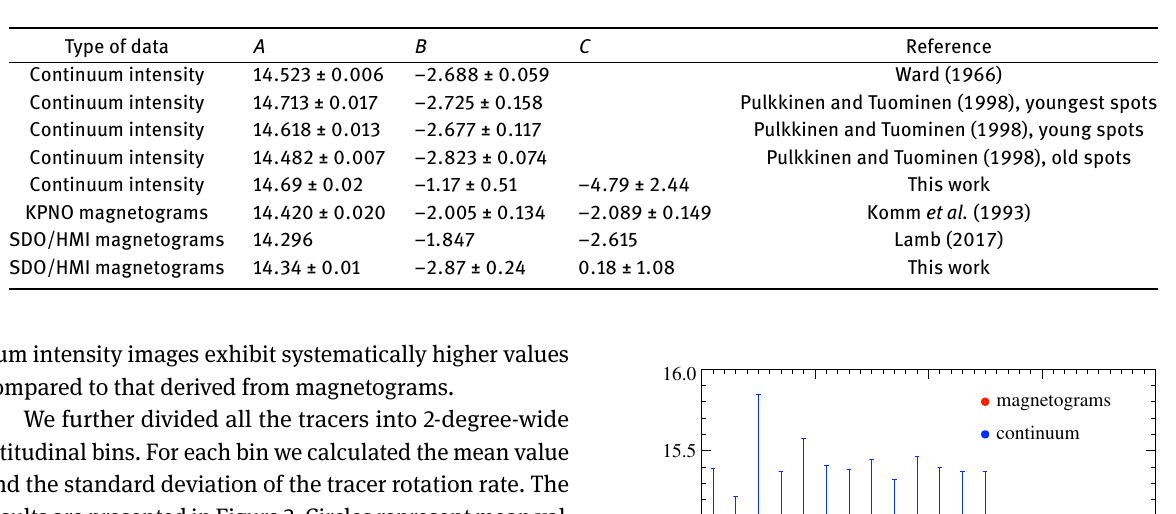
The distributions of the calculated differences for the rotation rates derived from magnetic field and continuum intensity data are shown in Figure 4 in orange and light blue colors, respectively. Red and blue curves represent the best fittings of the distributions by a Gaussian. The centers of the Gaussians are located at −0.023±0.004 and (0.391±0.028) ∘ day −1 for red and blue curves, respectively. The width of the Gaussians are 0.206±0.004 (red) and (0.626±0.028) ∘ day −1 (blue). A slight asymmetry in both distributions are clearly seen in Figure 4. The right-hand wingsofthedistributionsareheavy-tailed,i.e.thereisanex- cess of tracers with the rotation rates exceeding mean